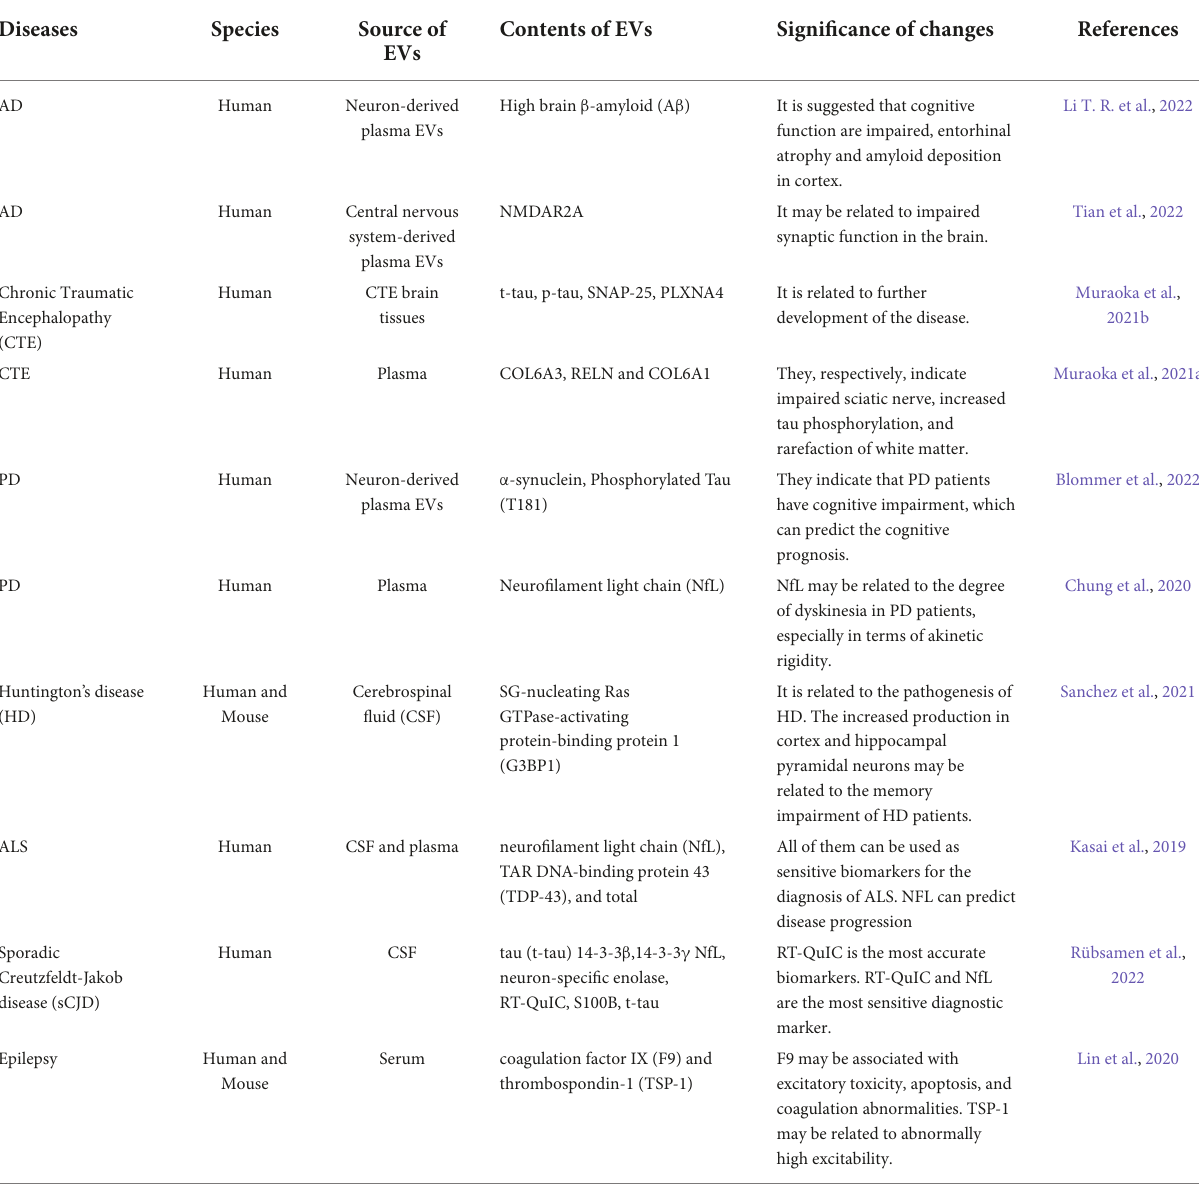
TABLE 2 EVs as the biological markers of neurodegenerative